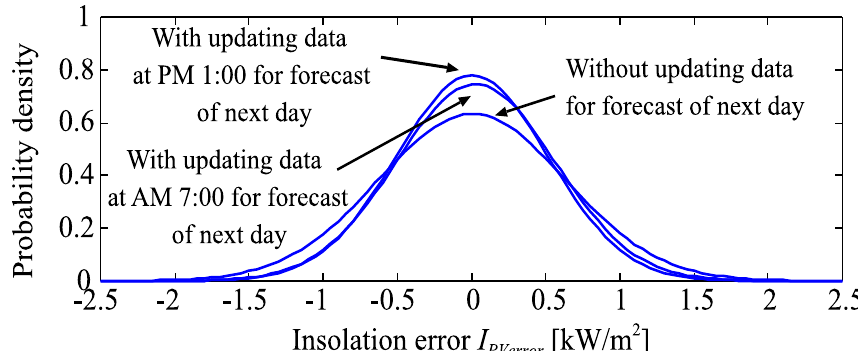
Figure 4. Forecast error for insolation with neural network